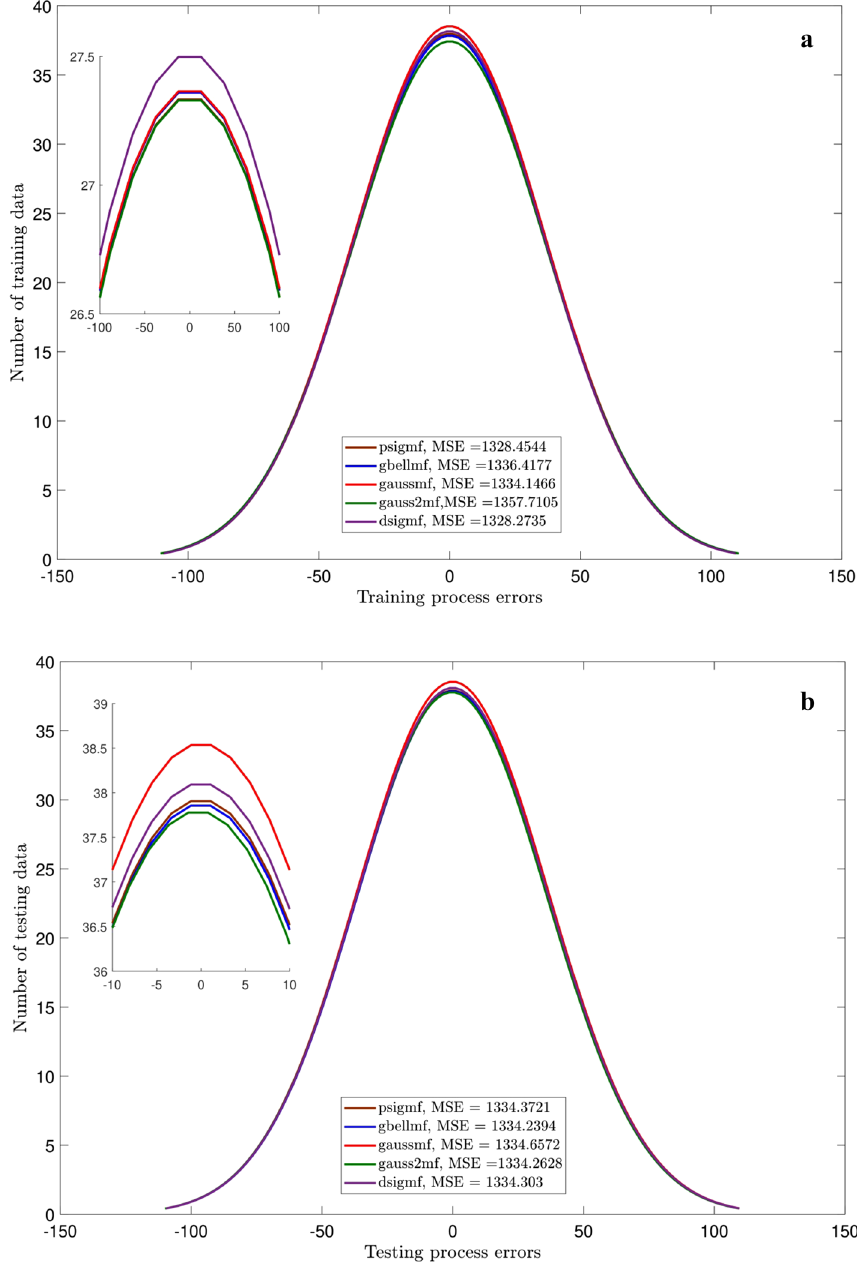
Figure 4. ( a ) Errors of training for different MF. Number of inputs = 3. ( b ) Errors of testing for different MF. Number of inputs =